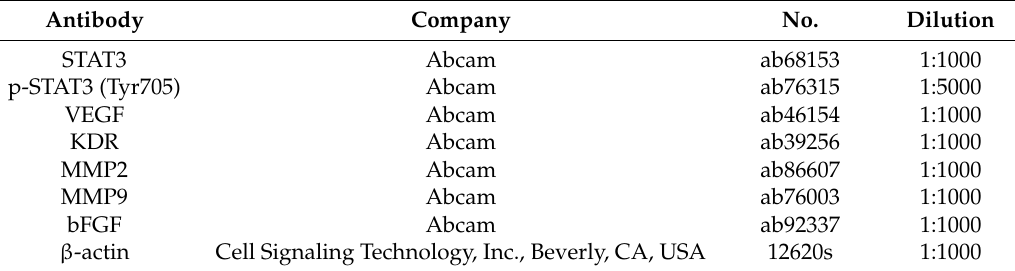
Table 1. Primary antibodies used by Western